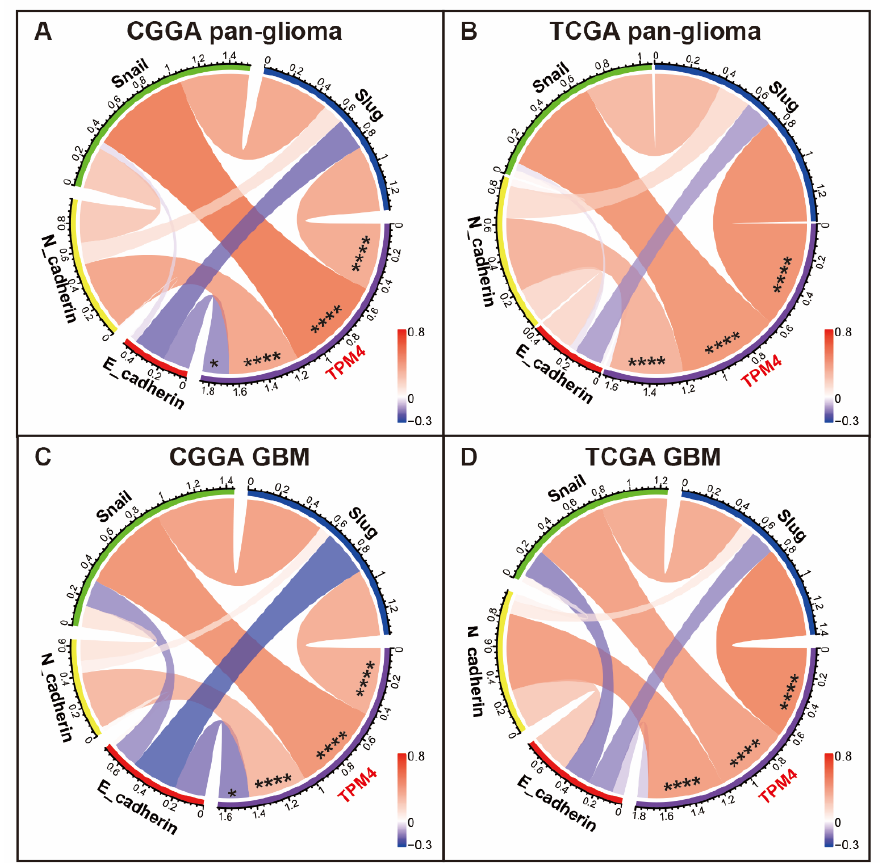
Figure 5. Correlation analysis between TPM4 and key EMT biomarkers in pan-glioma ( A , B ) and GBM ( C , D ). ( A ) Correlation analysis in CGGA pan-glioma. ( B ) Correlation analysis in TCGA pan- glioma. ( C ) Correlation analysis in CGGA GBM. ( D ) Correlation analysis in TCGA GBM. * indicates p value < 0.05. **** indicates p value <